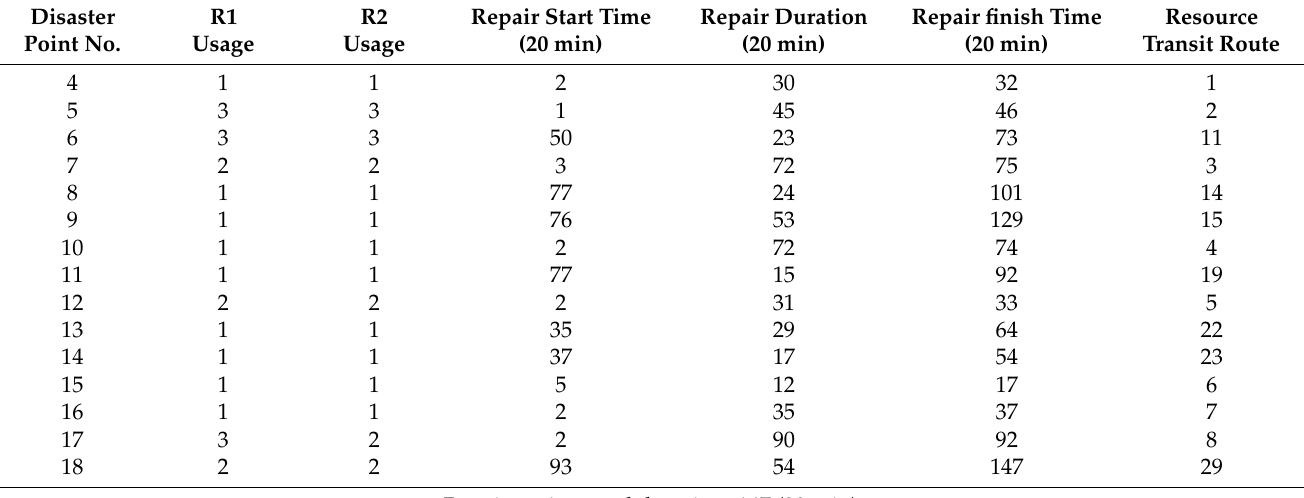
Table 5. Scheduling result for Case